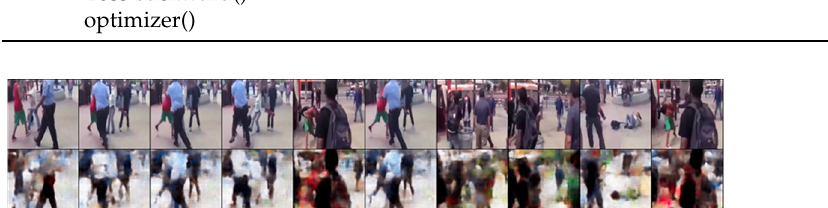
Table 5. Statistics on the number of video frames in the violence dataset.